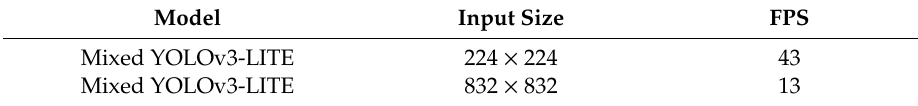
Table 10. Comparison of experimental results for di ff erent network